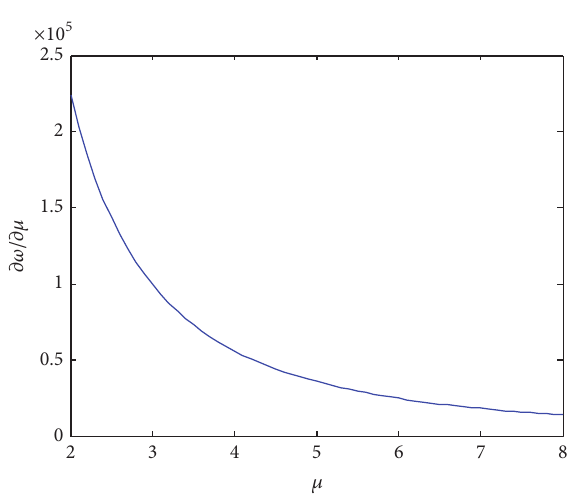
Figure 5: The relation of scale economy for regulation and trading market with 𝑢 = 5 ; 𝜏 𝜇 = 5 ; 𝜏 𝑤 = 3 ; 𝜑 1 = (0.1, 0.4) .